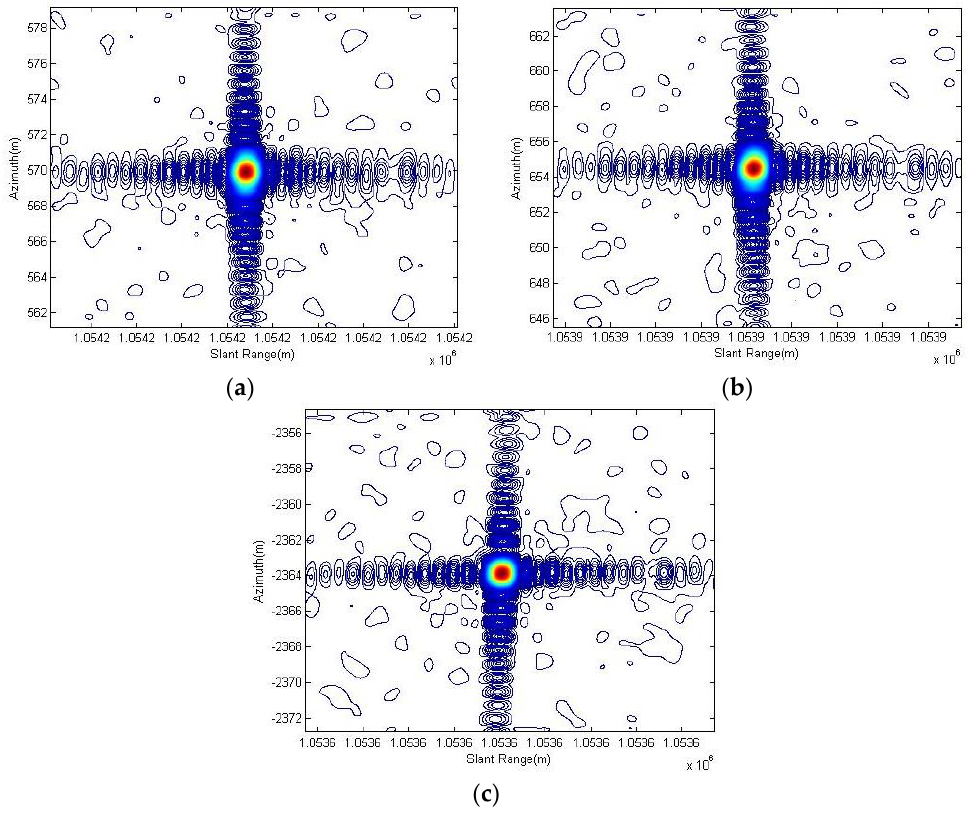
Figure 7. The contour images of corner reflector No. 1, corner reflector No. 2 and corner reflector No. 3 are shown in ( a – c ) respectively. These were given before the spotlight processor applied the enhancements. Table 3. Results before the spotlight processor applied the